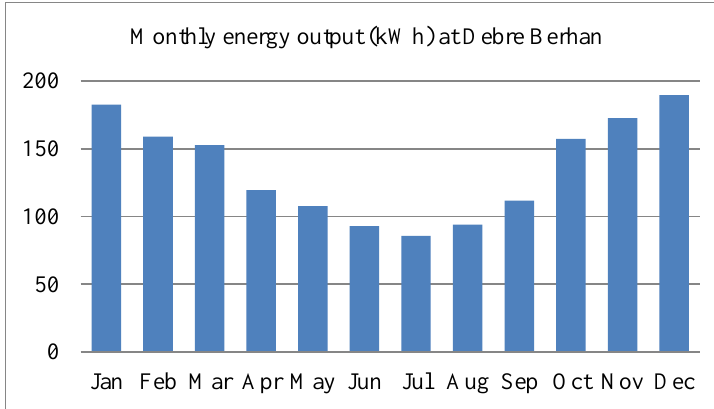
Figure 9. Energy assessment of solar system at Debre Berhan.